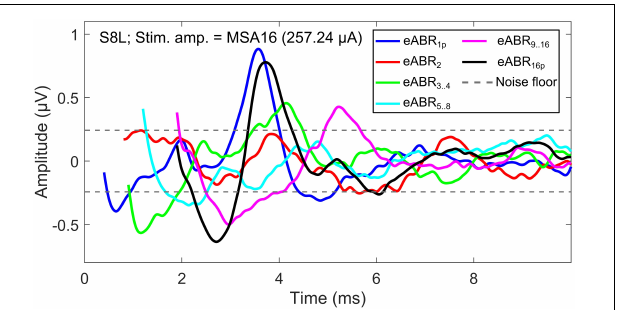
FIGURE 12 | eABRs to individual pulses and groups of pulses in the 16-pulse condition for subject S8L. Note the peaks and troughs of responses to successive pulses and groups of pulses, which suppress the response to the first pulse (eABR 1 p ). This destructive interference effect may explain the decrease in the eV amplitude in multi-pulse